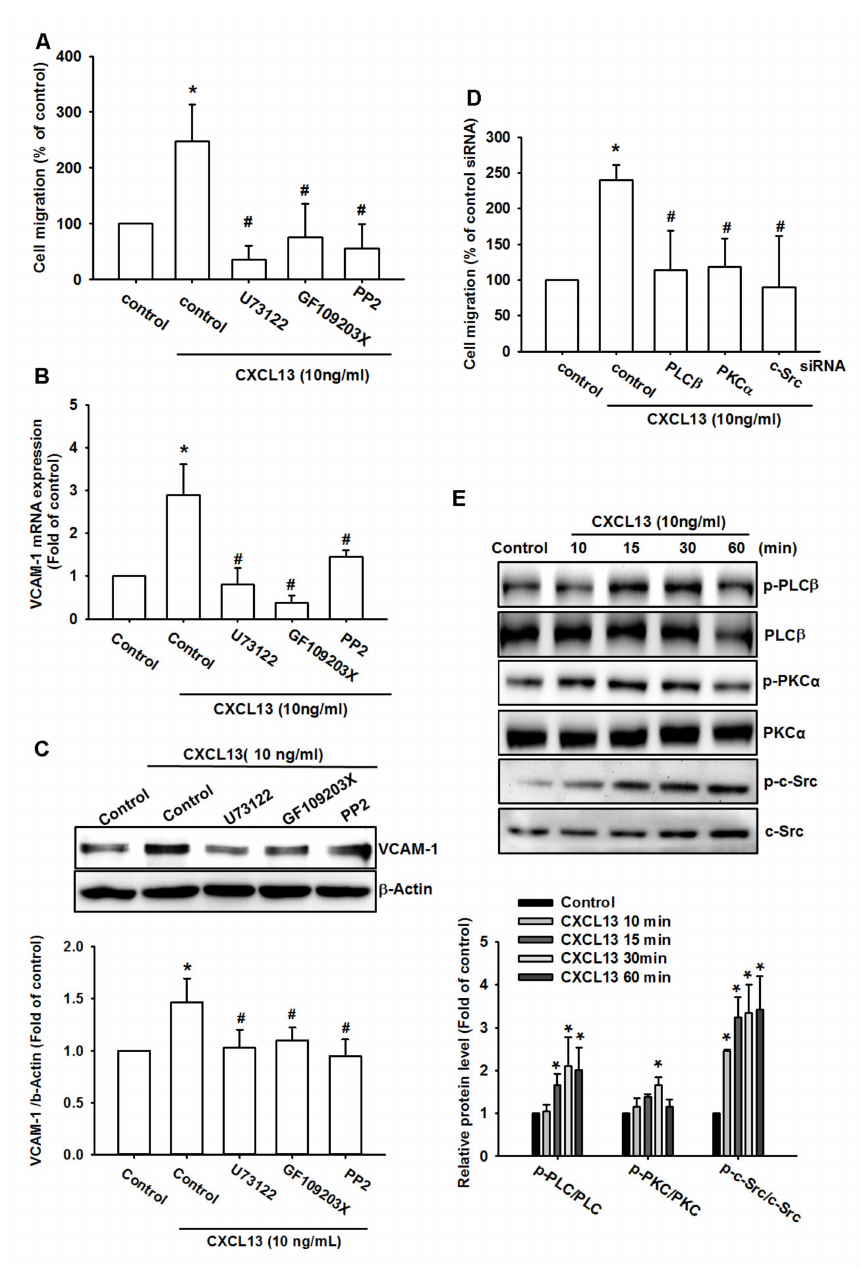
Figure 4. The phospholipase C β (PLC β ), protein kinase C α (PKC α ), and c-Src pathways are involved in CXCL13-promoted migration and VCAM-1 production. ( A – C ) MG-63 cells were pretreated with U73122, GF109203X, and PP2 then stimulated with CXCL13; migratory potential and VCAM-1 expression was examined by Transwell, qPCR and Western blot assays. ( D ) MG-63 cells were transfected with PLC β , PKC α , and c-Src siRNA then stimulated with CXCL13; migratory potential was examined by the Transwell assay. ( E ) MG-63 cells were incubated with CXCL13 for the indicated time intervals and PLC β , PKC α and c-Src phosphorylation was examined by Western blot. * p < 0.05 compared with the control group; # p < 0.05 compared with the CXCL13-treated